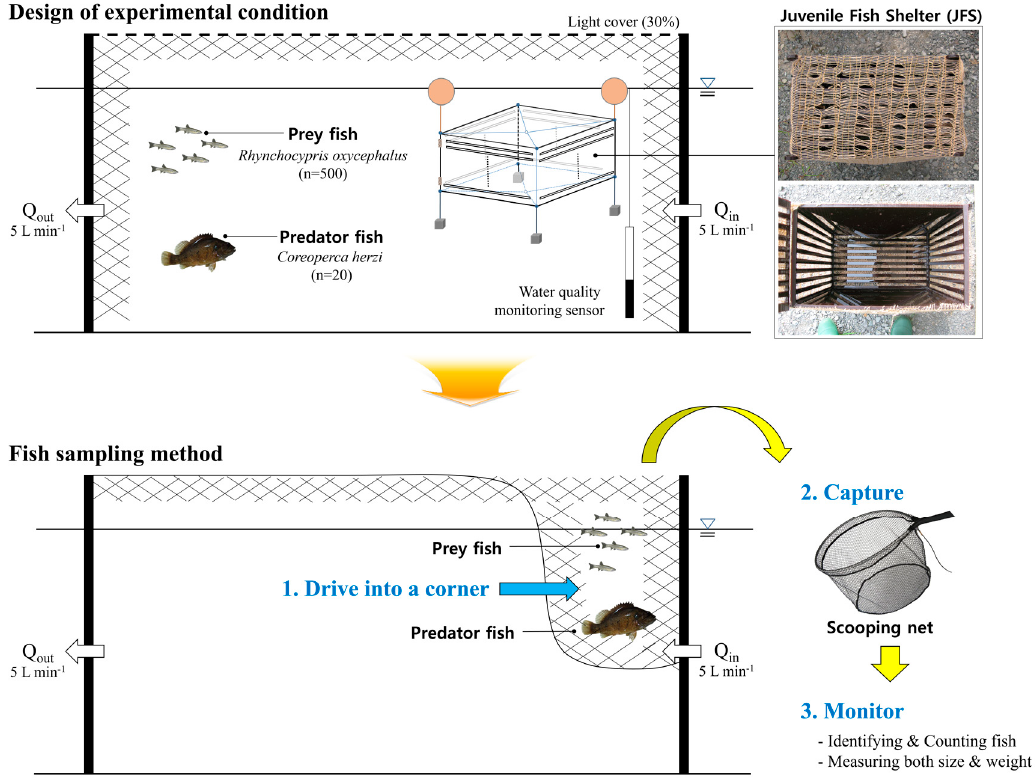
Figure 2. Experimental design of a juvenile fish shelter (JFS), and fish sampling method utilized in this study.